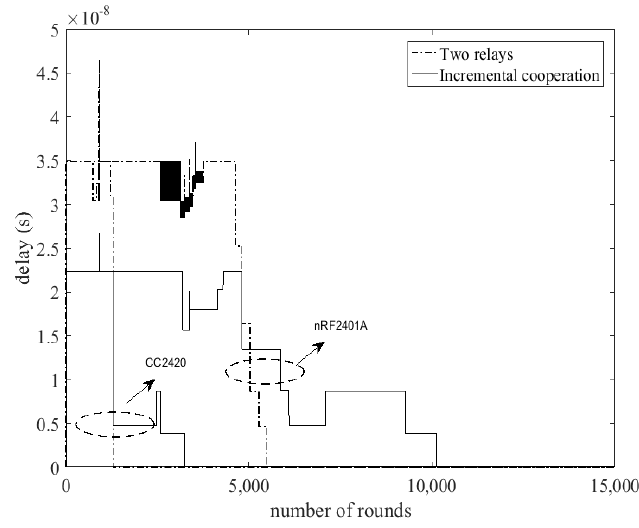
Figure 16. The propagation delay versus the network lifetime.